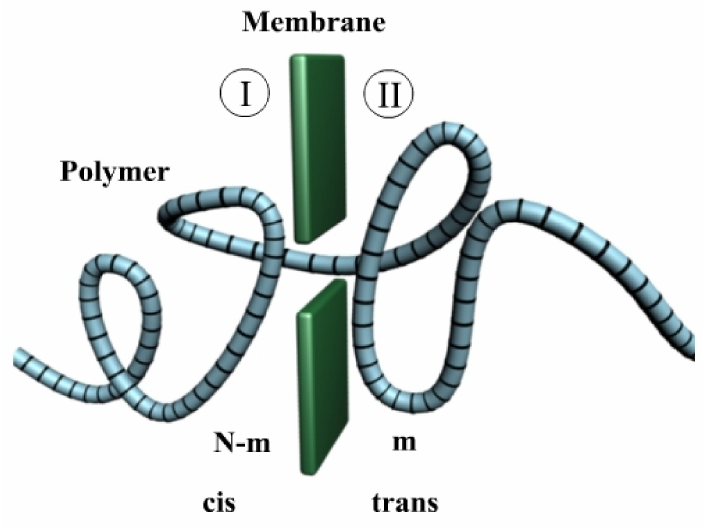
Figure 2. Polymer escape in transition, having m monomers in the trans area. I is the cis area, while II is the trans